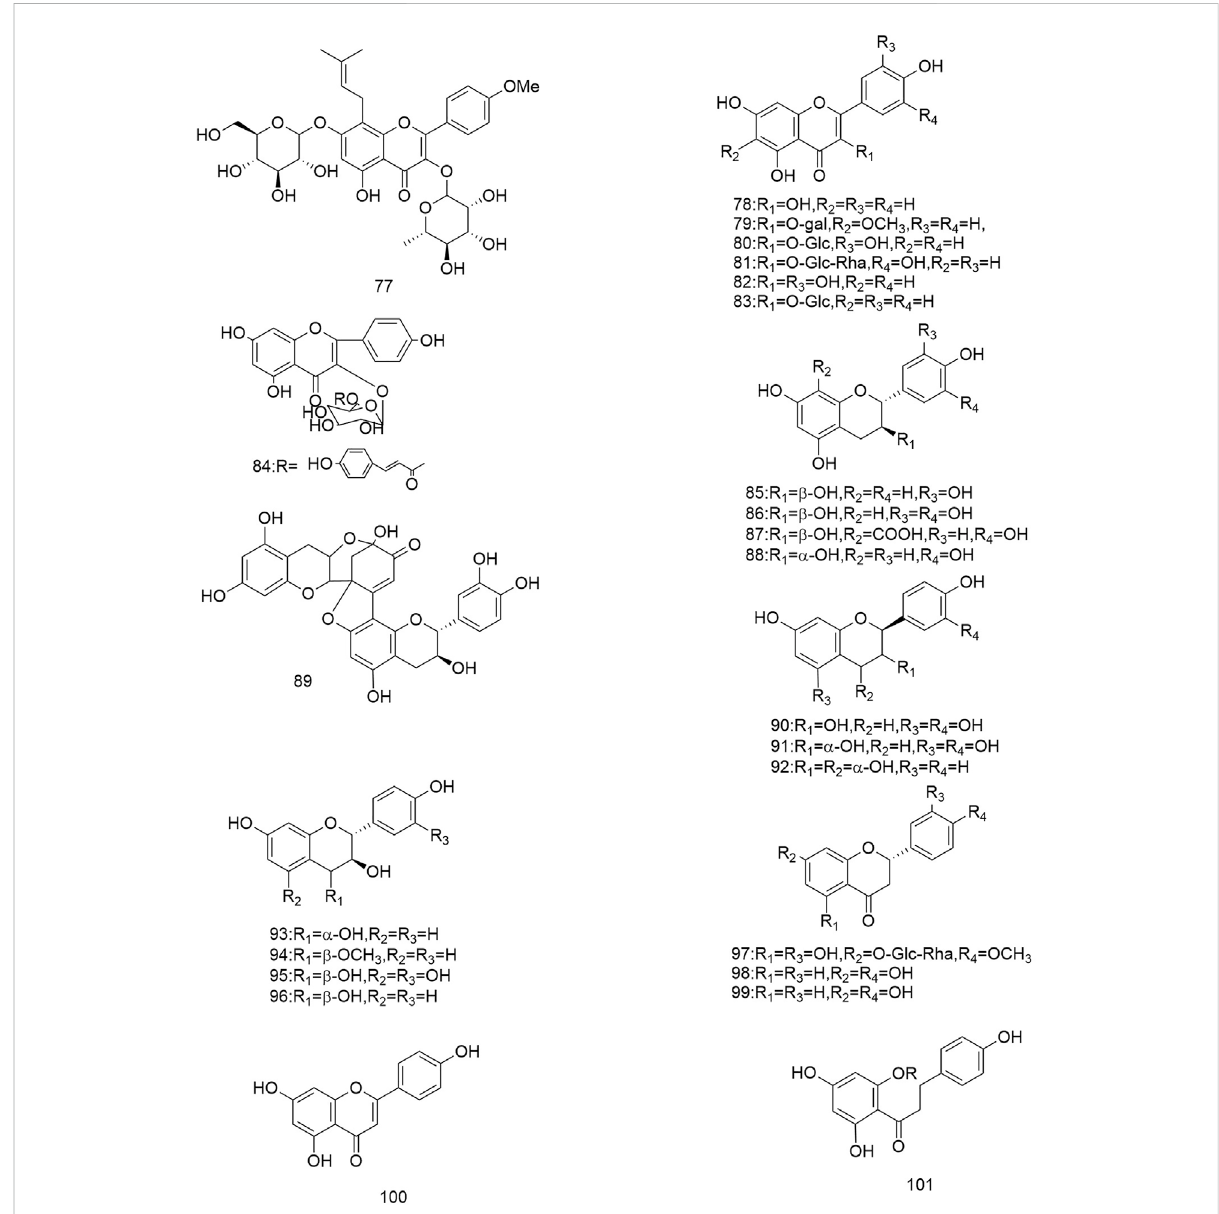
FIGURE 3 Diagrammatic representation of the structural formulas of fl avonoids of compounds found in R. laevigata